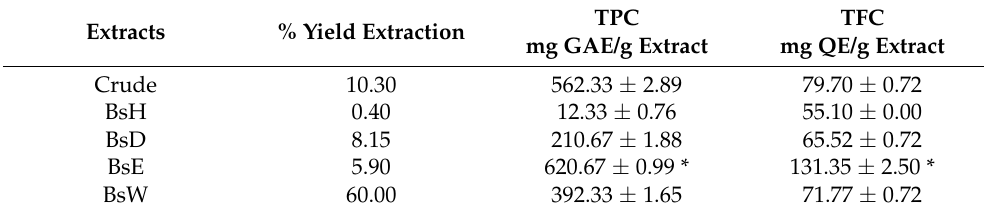
GAE: gallic acid equivalent; QE: quercetin equivalent. * Indicates statistical difference, when compared with other